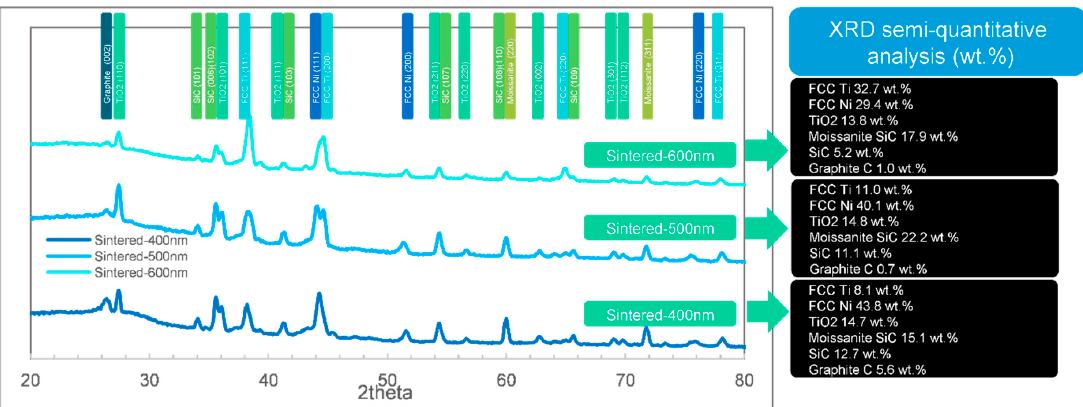
Figure 9. The XRD phase identifications (semi-quantitative analysis) by FWHM of the normally-sintered samples ranging from 400 to 600 nm.